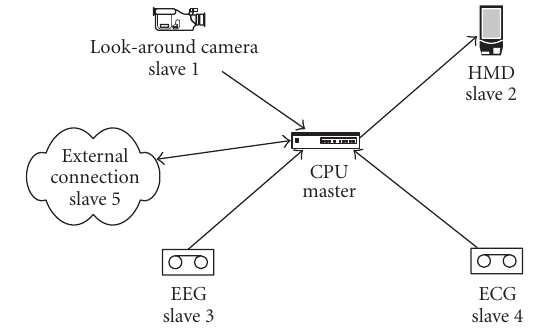
Figure 4: Bluetooth wireless sensor network, showing master and slave nodes. Table 2: Tra ffi c flows across the simulated wearable network (from Figure 4, S1 = Slave 1, S2 = Slave 2, ... M = master node).